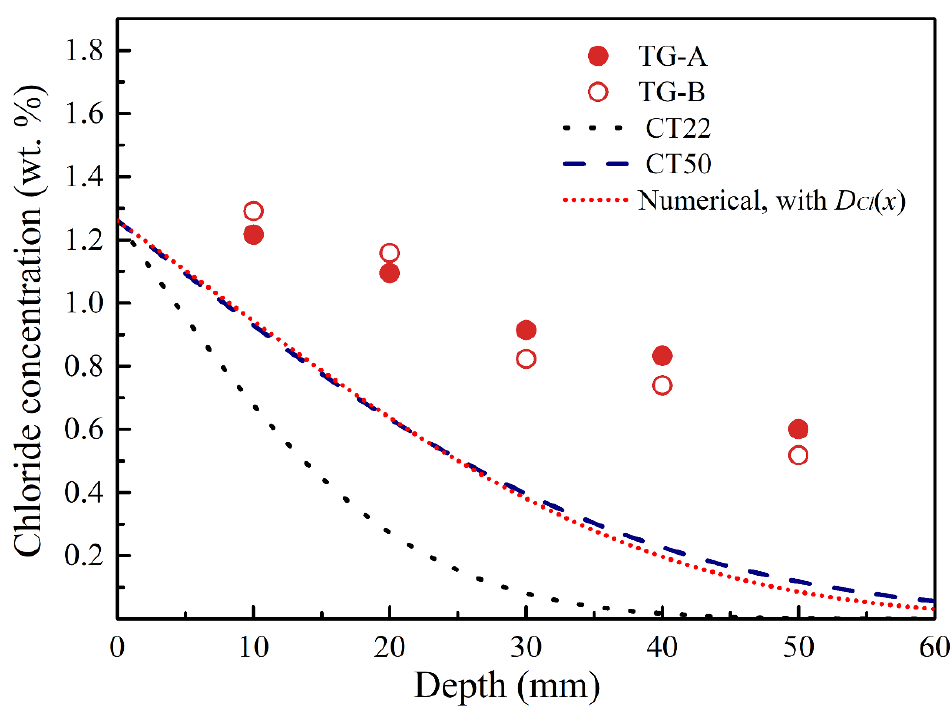
Figure 7. The chloride concentration profile of calculation results by considering the diffusion coefficient, 𝐷 𝐶𝑙 (𝑥) , as a function of x , compared with measured concentration profiles. (Single-column fit)